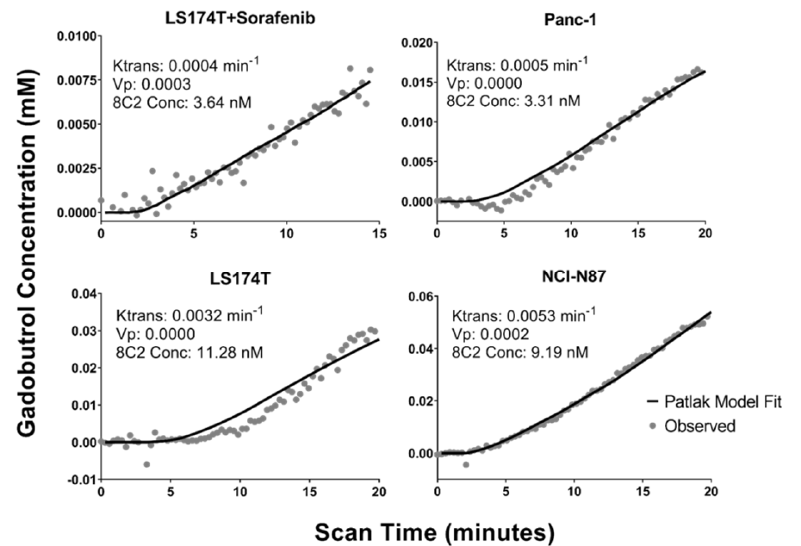
Figure 4. Representative DCE-MRI Data: Observed gadobutrol tumor concentrations (gray dots) and Patlak model fittings (solid black lines) are shown for xenograft tumors that were collected three hours after 8C2 administration. Fit Patlak model parameters for K trans and Vp are provided for each tumor in addition to the observed 8C2 concentration at 3 h